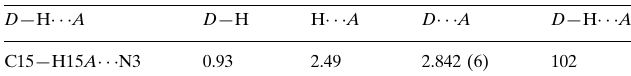
Hydrogen-bond geometry (A˚ , (cid:1)